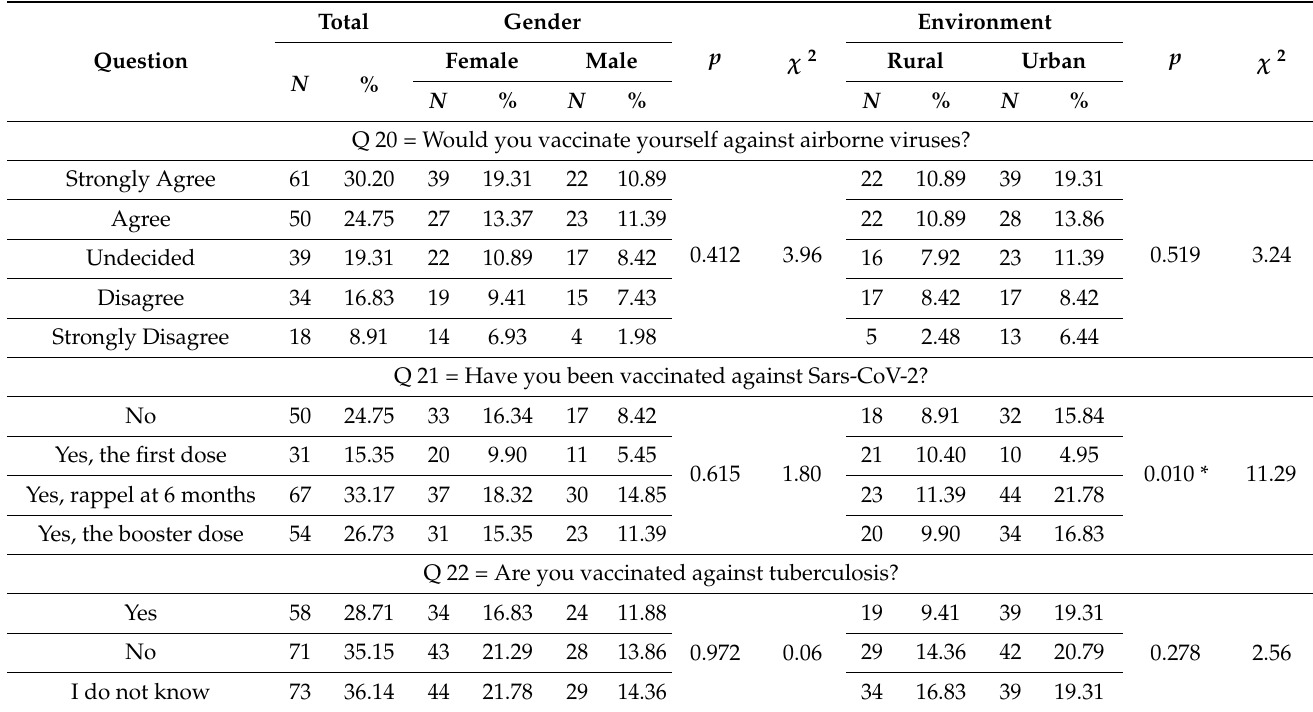
Table 4. The distribution of answers concerning the compliance of the subjects regarding the admin- istration of vaccines for diseases transmitted through the air.